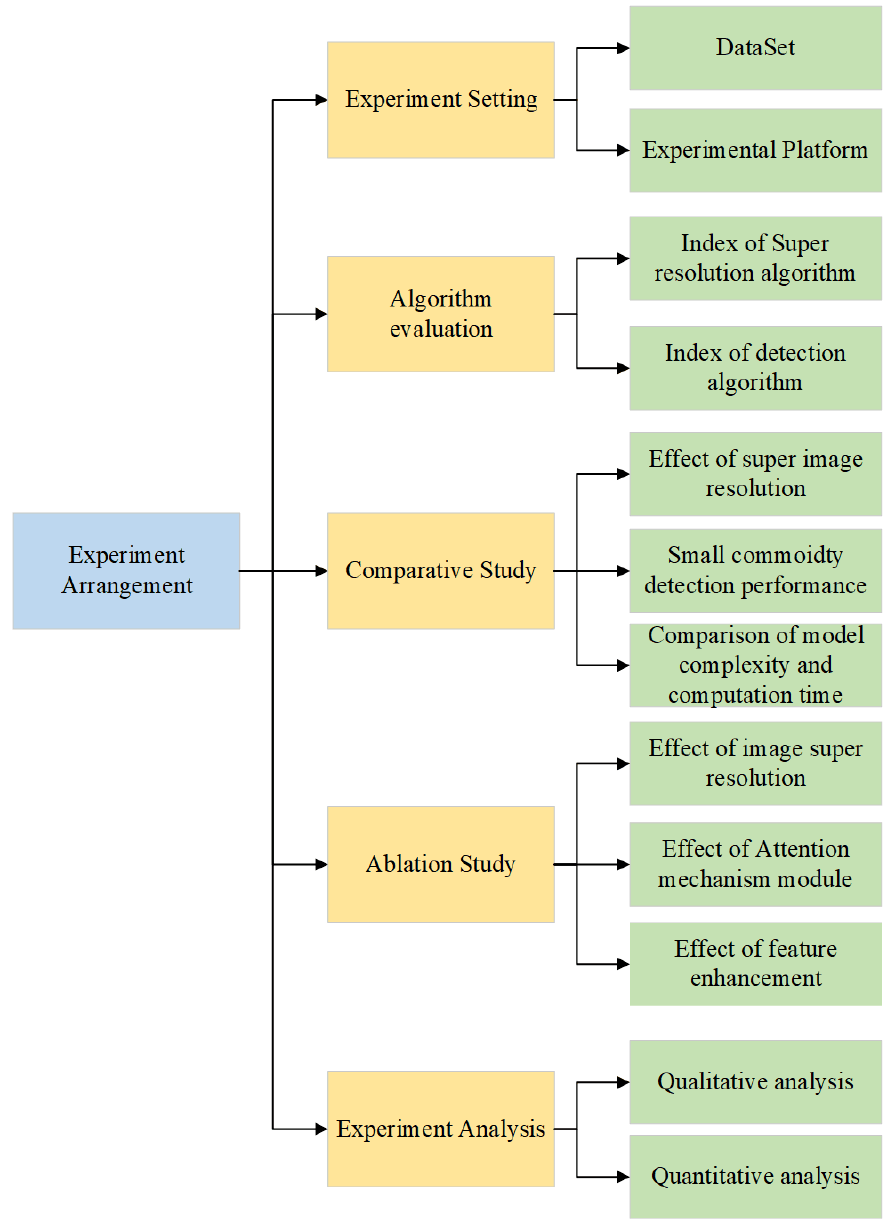
Figure 7. Overview of experiment arrangement.